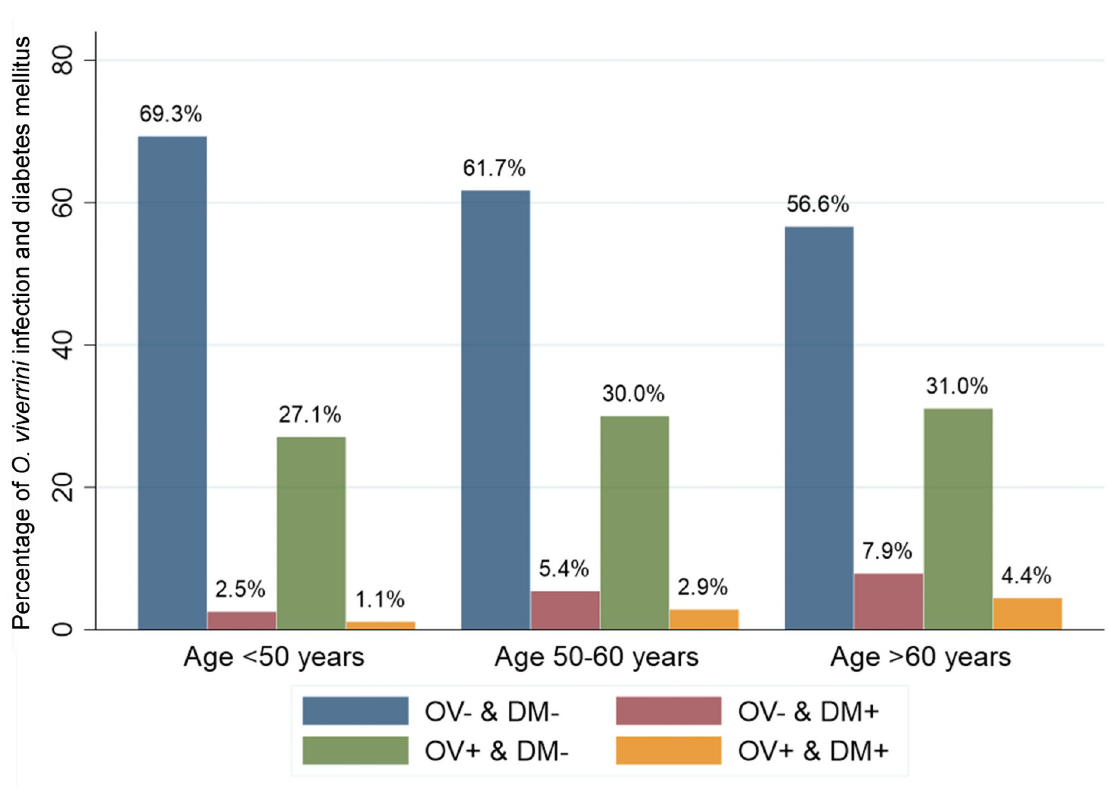
Fig 3. Breakdown of study population according to O . viverrini infection and diabetes mellitus status. Data show percentages of the study population falling into each of the four possible combinations of O . viverrini infection and diabetes mellitus status according to age